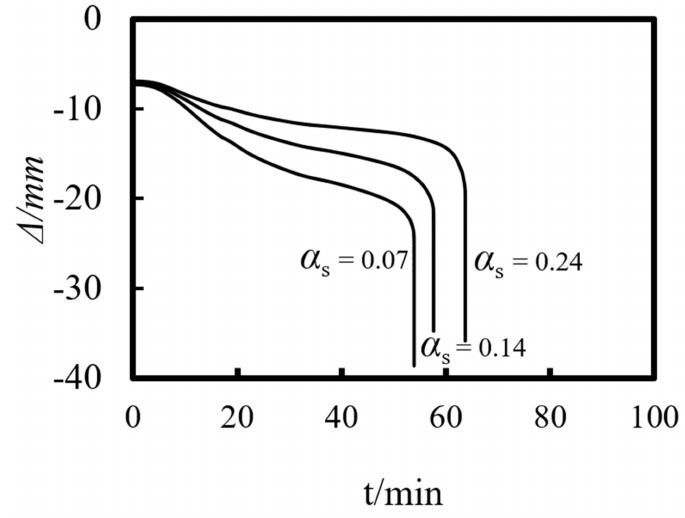
Figure 19. Effect of steel content on the axial deformation − time